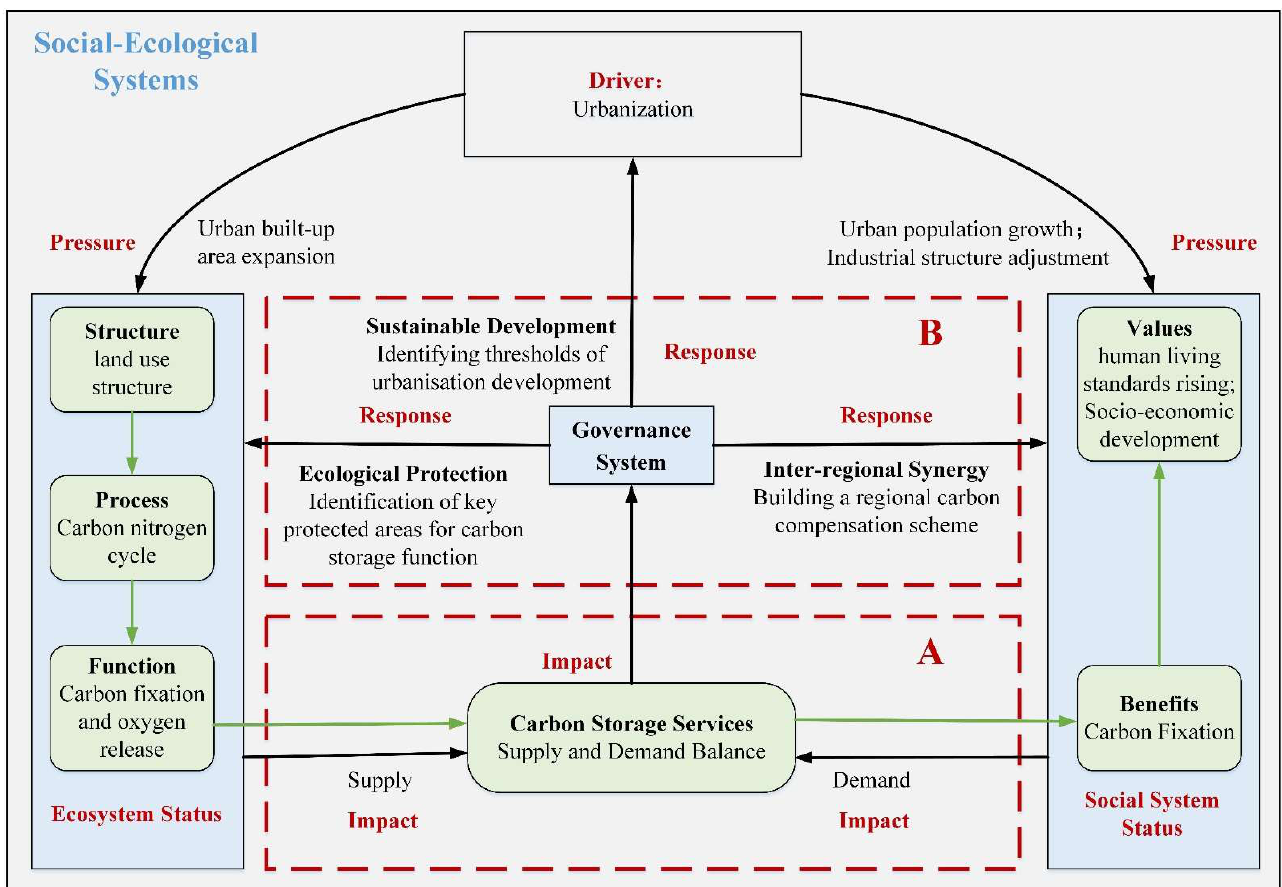
Figure 1. Theoretical framework of social-ecological systems.